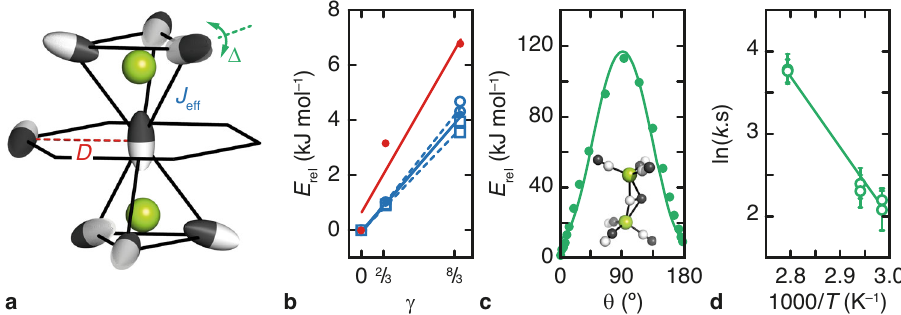
Fig. 3 Microscopic single-ion and pairwise interaction parameters in Cd(CN) 2 . a The effective exchange interaction (strength J eff ) operates between nearest neighbours within the same pyrochlore sublattice. Dipolar interactions (strength D ) give rise to an effective exchange interaction between nearest neighbours on alternate sublattices. The single-ion anisotropy term 4 re fl ects the enthalpy barrier to CN – reorientations. b Relative DFT energies E rel for a series of single network ( fi lled blue symbols) and interpenetrated ( fi lled red symbols) Cd(CN) 2 con fi gurations with different CdC n N 4 – n coordination ð n (cid:3) 2 Þ 2 ¼ 0), CdC γ ¼ 2 environments: CdC 2 N 2 (geometric parameter γ ¼ 2 ) and CdC 4 /CdN 4 ( γ ¼ 8 ). Simple geometric arguments give 3 N/CdCN 3 ( 3 3 3 E ¼ γ J þ D Þ for single-network and interpenetrated Cd(CN) and γ ð J 2 , respectively. The corresponding NMR-derived values are shown with open blue rel eff eff symbols (squares = ref. 34 circles = this study). c Nudged elastic band calculation energies for a 180° CN – orientation fl ip ( fi lled green symbols) and θ ð Þ ¼ 4 cos 2 θ ¼ 4 S 2 4 was obtained. The 4 ’ 90° transition state involves a C-bridged corresponding fi t E k (solid green line), from which the value of rel Cd – (CN) – Cd linkage (inset) and a reduced Cd … Cd separation. d Arrhenius plot re fl ecting the temperature dependence of CN – fl ipping rates as determined using 113 Cd EXSY spectroscopy. Error bars denote the standard error in rate constants determined extracted during fi tting (see Supplementary Figure 6 and Supplementary Table 7). The experimental value of 4 is given by the gradient of the linear fi t (solid